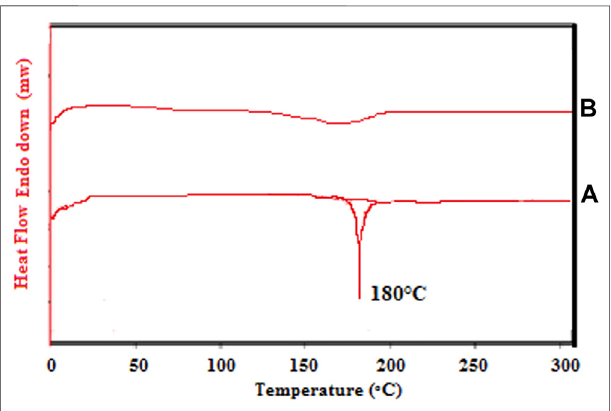
FIGURE 5 | DSC thermograms [A-pure CMN and B-Optimized CMT (M14)].